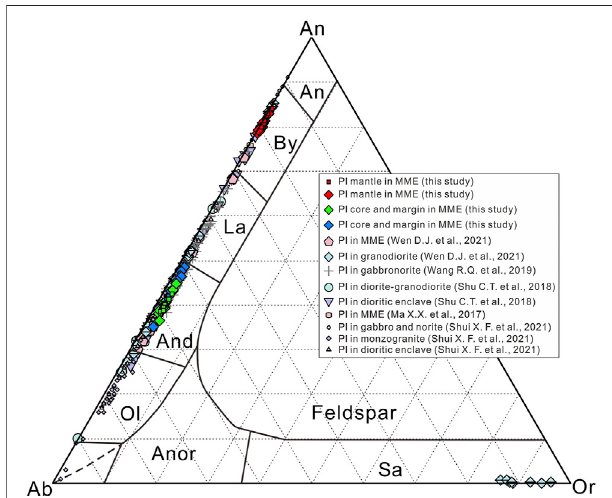
FIGURE 13 | Chemical classi fi cation of plagioclase on a ternary diagram (anorthite-albite-orthoclase)forplagioclase.Abbreviations:An,anorthite;And, andesine; Anor, anorthoclase; By, bytownite; La, labradorite; Ol, oligoclase; Sa, sanidine.